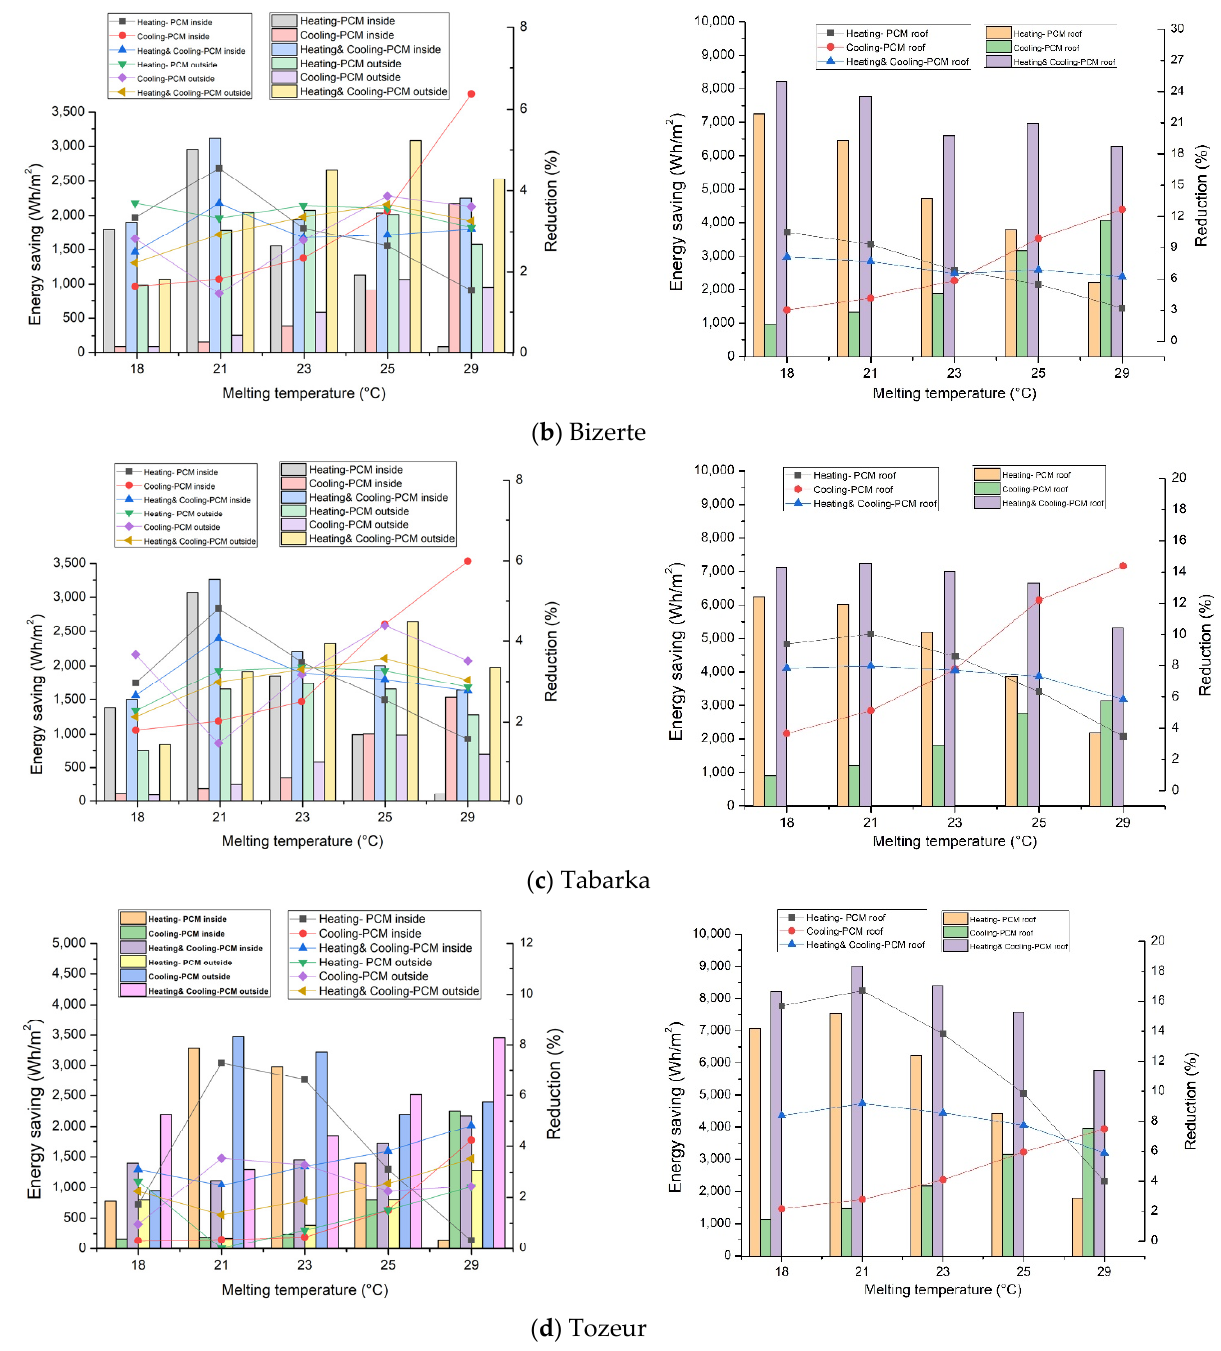
Figure 6. E ff ect of PCM melting temperature on energy saving and energy reduction. Figure 6. Effect of PCM melting temperature on energy saving and energy